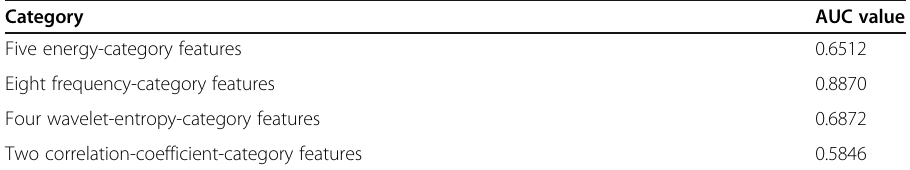
Table 4 AUC values for different feature categories based on a fivefold cross-validation